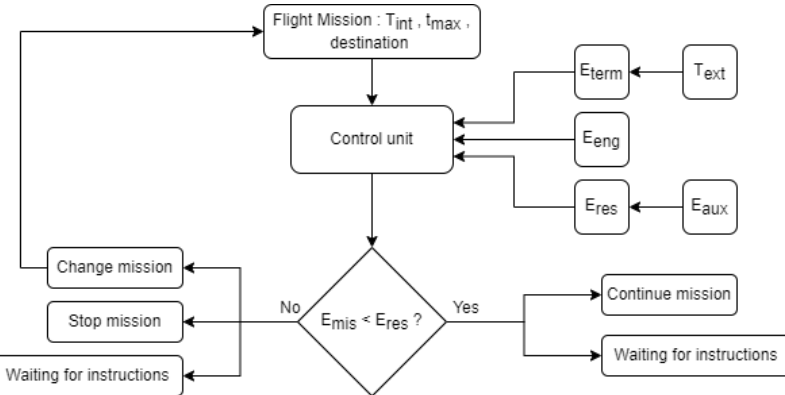
Figure 2. Schematic diagram of the temperature control